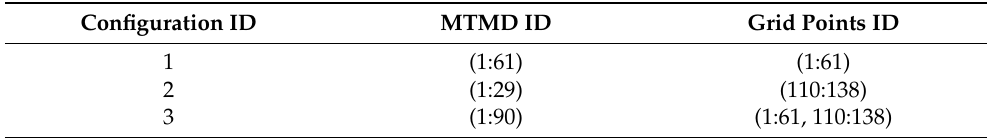
Table A1. MTMD identification according to the grid point numbering of the FE model of the truss-like